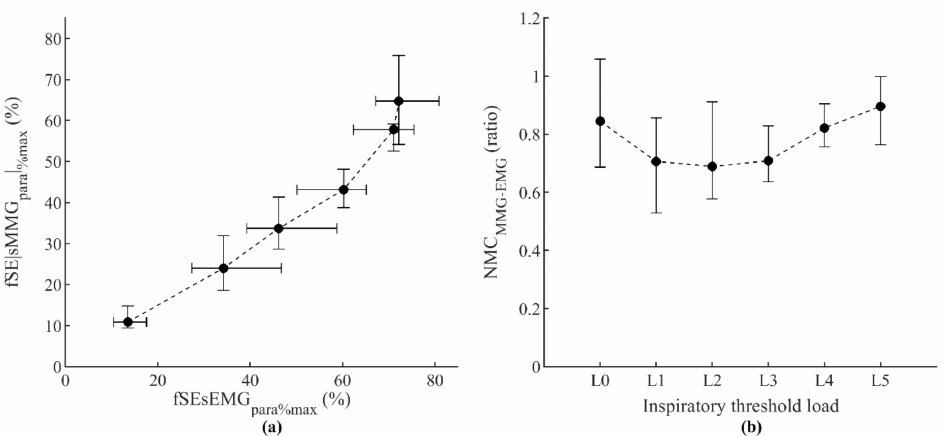
Figure 4. Relationship between fixed sample entropy measurements of surface mechanomyography (fSE|sMMG para | %max ) and surface electromyography (fSEsEMG para%max ) of the parasternal inter- costal muscles ( a ) and the corresponding neuromechanical coupling ratio (NMC MMG-EMGpara ) ( b ), during the incremental inspiratory threshold loading protocol. Data points represent median and interquartile range of the 12 subjects for each